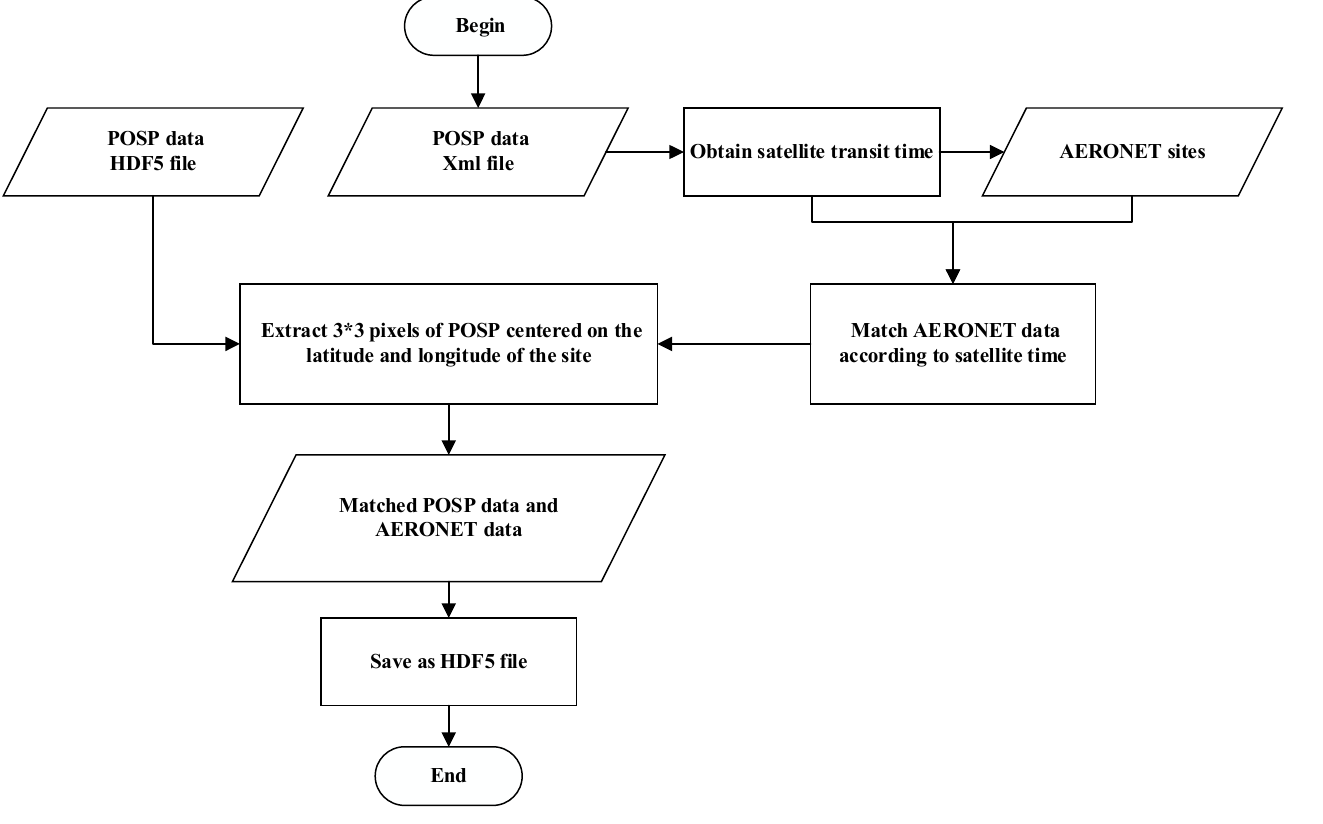
Figure 4. The flowchart of matching POSP observation data and AERONET data.